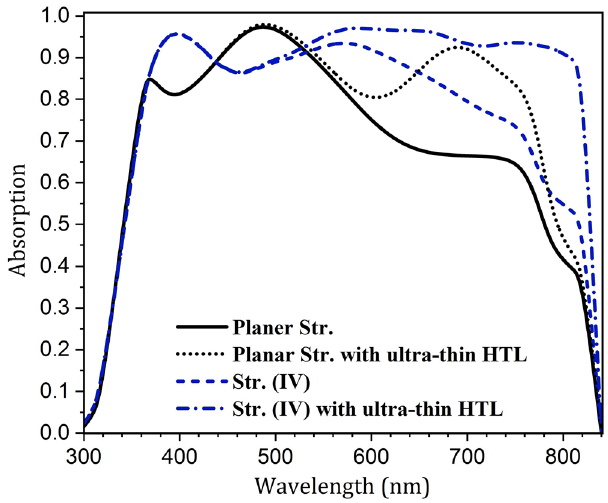
Fig. 8. Normalized absorption of the active layer in the ultra-thin HTL structure in the presence and absence of